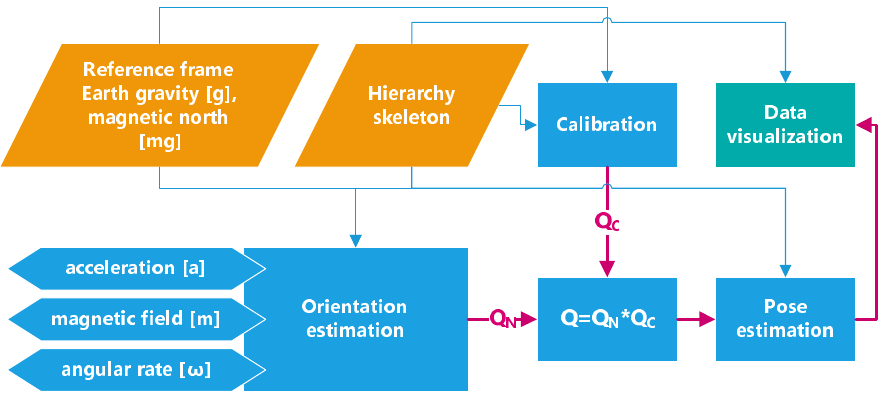
Figure 1. Data processing pipeline.